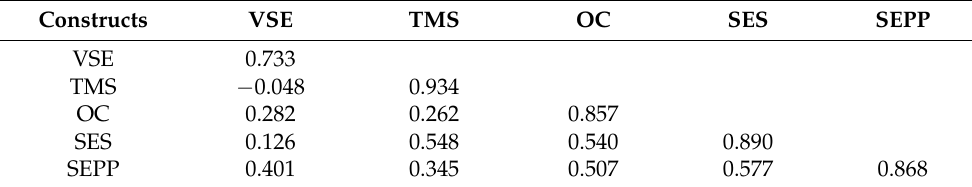
Table 7. Discriminant Validity.